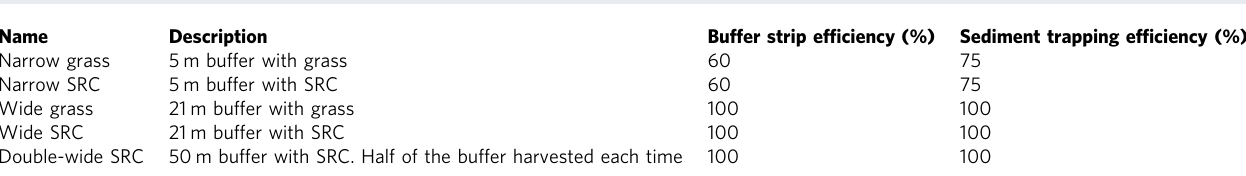
Table 3 Options for riparian buffer systems and corresponding buffer strip ef fi ciency for reducing N emissions to water, and sediment trapping ef fi